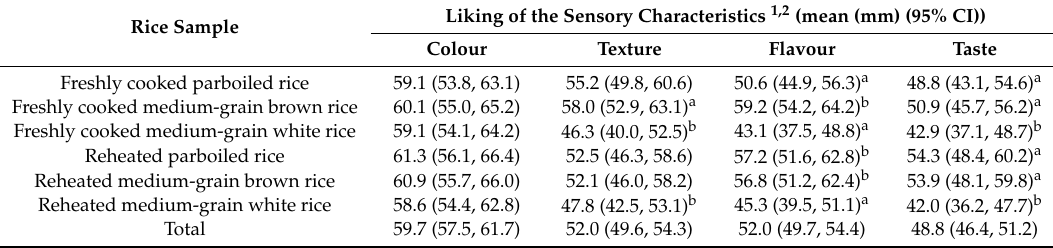
Table 2. Participant ( n = 64) liking scores (mm out of 100 mm) for colour, texture, flavour and taste, and overall acceptability of each cooked plain rice